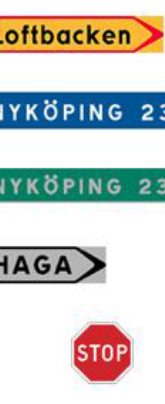
Figure 2. Randomly selected road signs in VTI data.